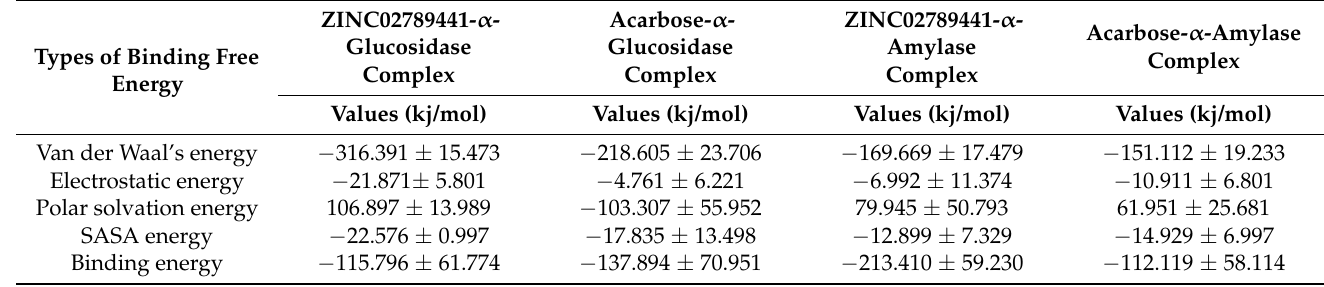
Table 10. Results of binding free energy calculations obtained using MMPBSA